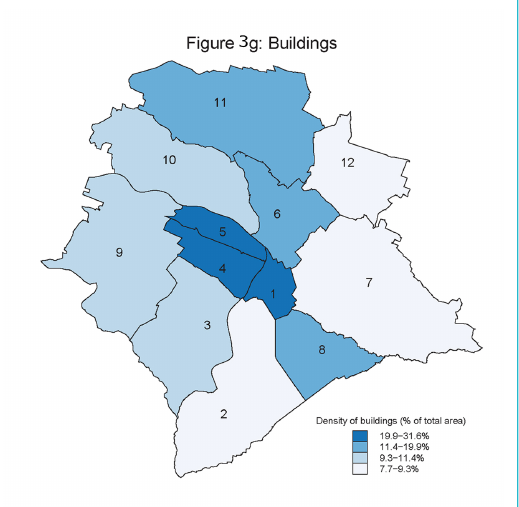
Figure 3e: Map of the City of Zurich showing proportion of green areas in different districts (intensity of the colour symbolises the quantity of proportion; dark = high proportion, light = low propor- tion) (n = 7145).